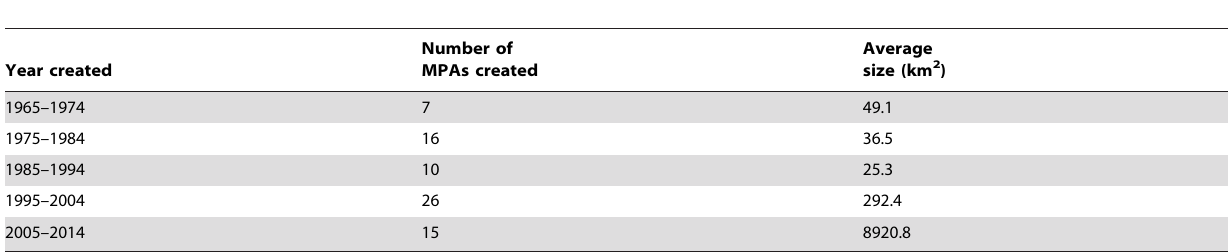
Table 2. Mean area of MPAs in the Western Indian Ocean and numbers existing by decadal creation date.